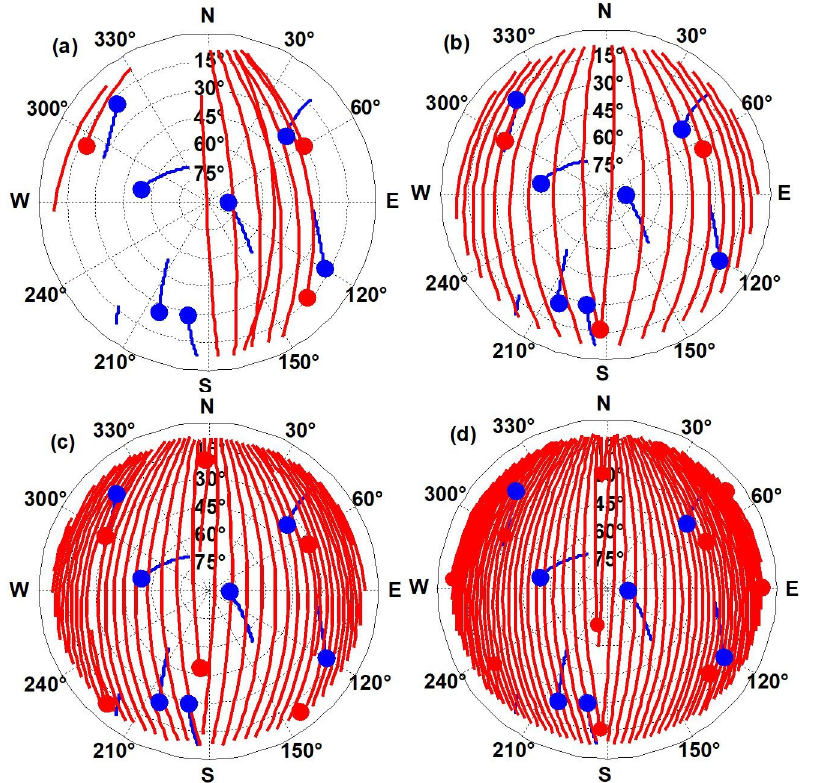
Figure 6. The 1-h sky plots (azimuth versus elevation) of GPS with the augmentations of different LEO constellations: ( a ) GPS+60 LEO; ( b ) GPS+96 LEO; ( c ) GPS+192 LEO; ( d ) GPS+288 LEO. Circular markers indicate the satellite (GPS in blue, LEO in red) positions at the initial epoch.